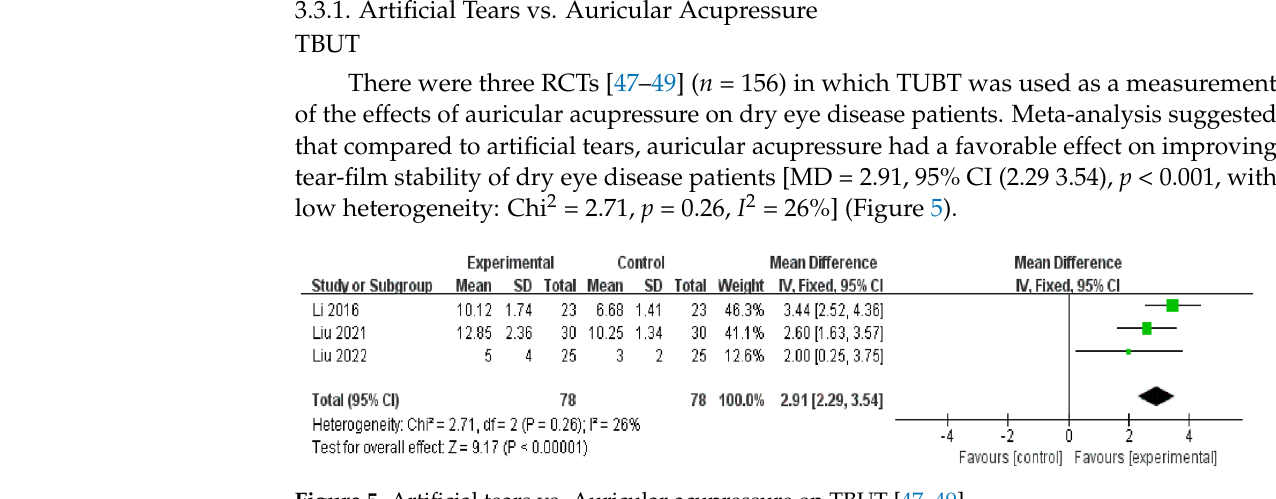
Figure 5. Artificial tears vs. Auricular acupressure on TBUT [47–49]. SIT effect of auricular acupressure on patients with dry eye diseases. Two of the RCTs [47,48] indicated positive effects on SIT between groups, while the remaining one [49] did not.